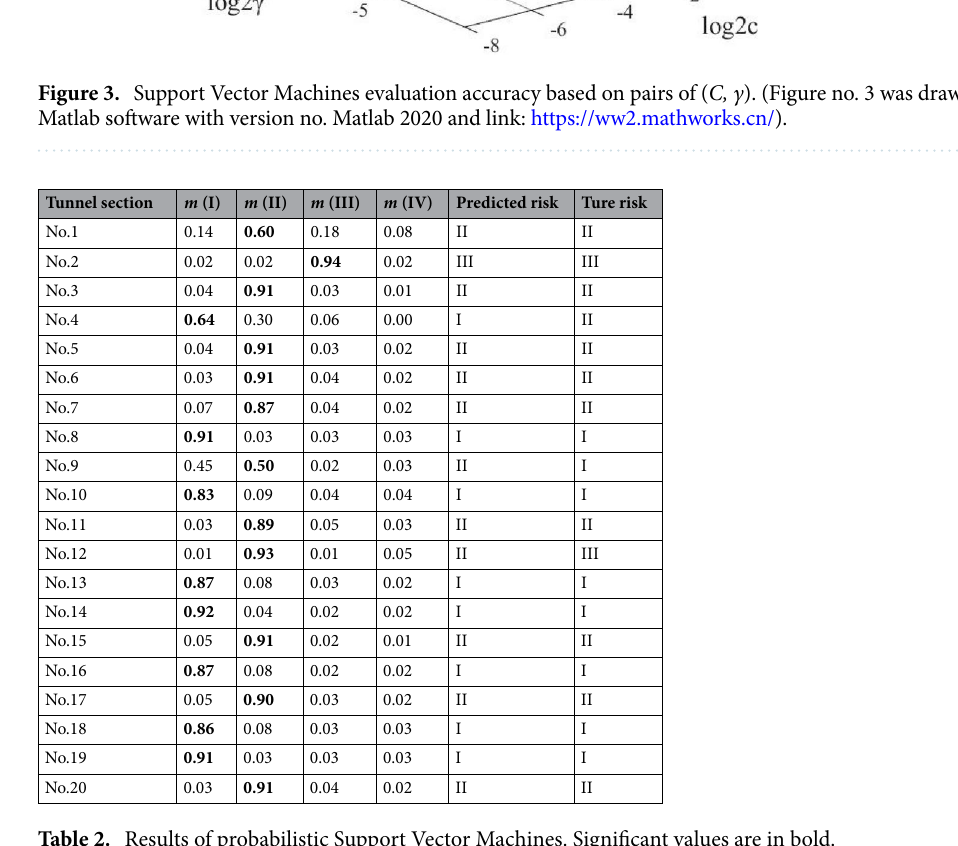
Table 2. Results of probabilistic Support Vector Machines. Significant values are in bold.